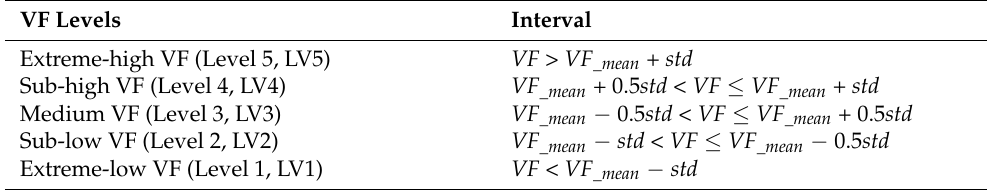
Table 3. Vegetation fraction